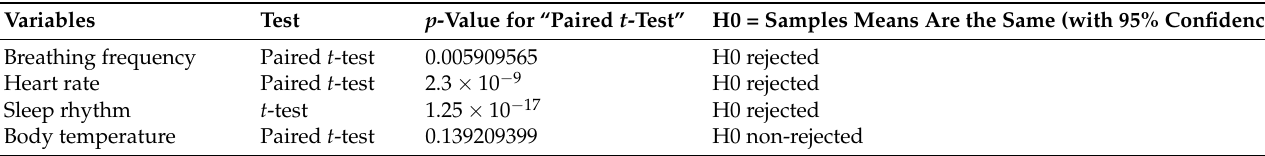
Table 14. Result of difference of means test for female